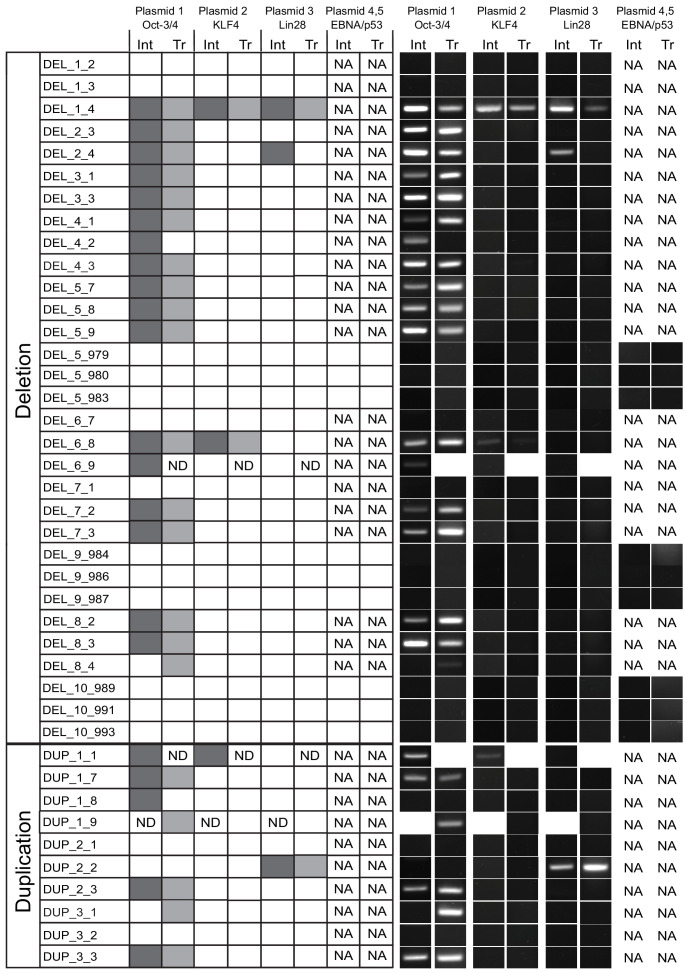
Presence of 16p11.2 reprogramming vector integration and transcripts.PCR was used to detect reprogramming vector constructs in genomic DNA, and RT-PCR was used to detect mRNA transcripts from each plasmid. Many of the clones were positive for both OCT4 plasmid DNA and transcript. Some clones were also positive for KLF4 or LIN28 plasmid, but no transcripts were detected. A subset of available clones was reprogrammed using additional plasmids carrying EBNA and p53 sequences. No reprogramming vectors were detected in these lines. Plasmid 1 - pCXLE-hOCT4-shp53-F (Addgene plasmid: 27077), plasmid 2 - pCXLE-hUL (L-MyC and Lin28; Addgene plasmid: 27080), plasmid 3 - pCXLE-hSK (Sox2 and KLF4; Addgene plasmid: 27078). Plasmids 4 - pCE-mp53DD (Addgene plasmid: 41856) and plasmid 5 - pCXB-EBNA1 (Addgene plasmid: 41857). Abbreviations: Int, Vector integrant PCR product; Tr, Vector transcription RT-PCR product; ND, not determined; NA, not applicable.